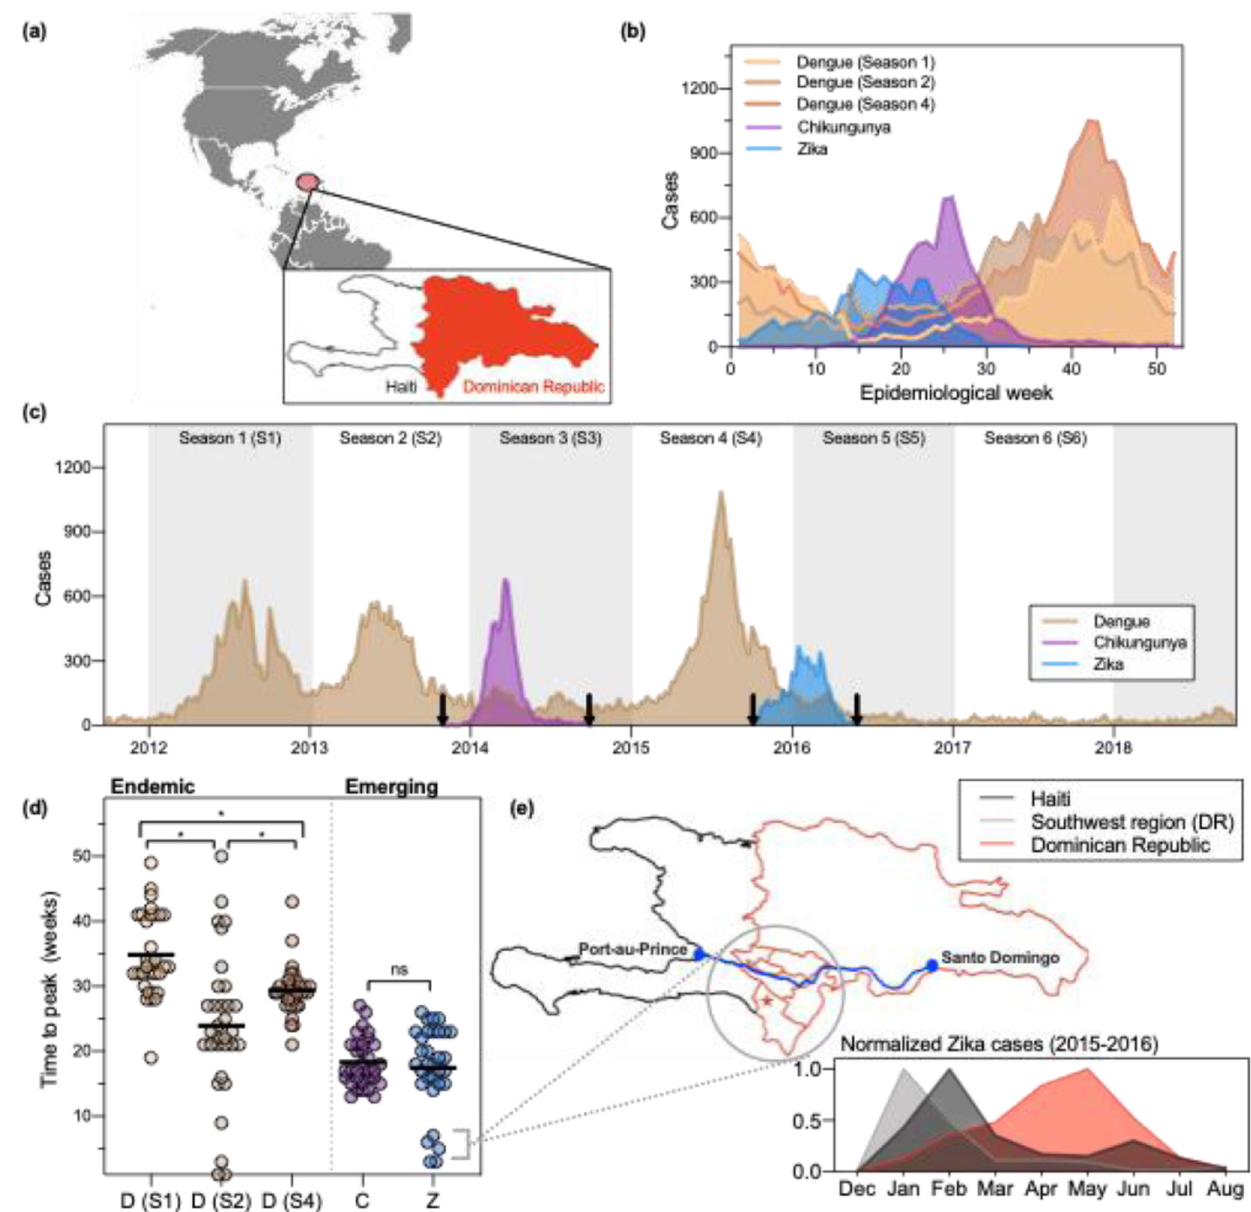
Fig. 1 Two outbreaks of emerging disease, chikungunya and Zika, and three endemic dengue outbreaks were reported between 2012 and 2018 in the Dominican Republic. a The Dominican Republic is a country in the Caribbean that shares the island of La Hispaniola with Haiti. Map source (gray): free vector maps. b Cases in the Dominican Republic reported by the Ministry of Health during each outbreak per epidemiological week for fi ve seasons. c Weekly reported cases from 2012 to 2018. Arrows indicate when the fi rst and last cases were reported for emerging pathogens. d Number of weeks elapsed between the fi rst case reported nationally and peak cases reported in 32 provinces (each data point represents a different province). The chikungunya outbreak began during epidemiological week (EW) 6, the Zika outbreak during EW 1, and the three dengue outbreaks during EW 14. The mean time to peak for each outbreak were compared using ordinary one-way ANOVA. We adjusted for multiple comparisons using Tukey ’ s multiple comparisons test. The qualitative statistical result of the analysis did not change when the fi ve early Zika provinces were excluded. Symbols: “ ns ” indicates p value > 0.05, *indicates p ≤ 0.05, horizontal bars indicate the median time to peak for each outbreak. D(S1) vs D(S2): p < 0.0001; D(S1) vs D(S4): p = 0.0155; D(S2) vs D(S4): p = 0.0173; C vs Z: p = 0.9885. e Geographic and temporal comparisons of Zika cases reported by four provinces in the southwestern region of the Dominican Republic. A major roadway connects the Haitian capital Port-au-Prince to the southwestern region of the Dominican Republic (blue line, map) and Santo Domingo, the national capital. A large binational market is located in the province Pedernales (star, map). Similar to Haiti, provinces in the southwest experienced an earlier outbreak of Zika compared with the remaining 28 provinces epidemiological week 15, a rise in Zika cases was observed during the fi rst weeks of the year.